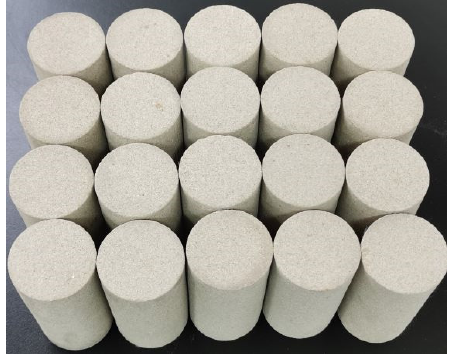
Figure 1. Coarse sandstone samples.